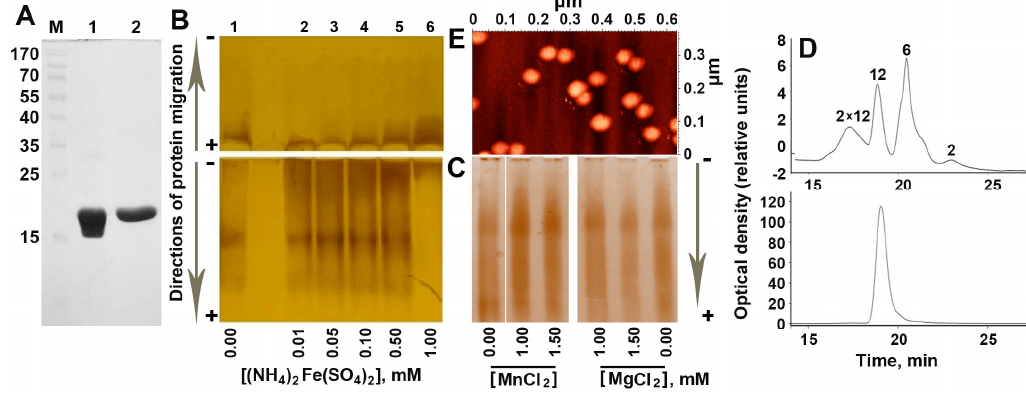
Figure 1. Oligomeric composition of the purified protein Dps. ( A ) The purity level of the protein obtained after ion exchange chromatography (lane 1) and gel filtration (lane 2) as revealed by SDS electrophoresis in 7.5% polyacrylamide gel. Protein marker lengths (M) are indicated in kDa. ( B ) Titration of purified Dps (100 μ M calculated for monomers or <8.3 μ M for dodecamers) with Mohr’s salt at pH 7.0. Lane 1—native Dps; lanes 2–6—fractional composition of the protein in the presence of 0.01–1 mM of Mohr’s salt, respectively. Vertical arrows on the left indicate the direction of electrophoretic fractionation. ( C ) The same for Dps titrated with MnCl 2 or MgCl 2 . ( D ) Elution profiles of the Dps from the gel-filtration column in the HPLC system for the purified protein (top panel) and Dps loaded with 1 mM Mohr’s salt (bottom panel). The concentration of Dps used in this experiment was 1 mg/mL (53 μ M for monomers). Oligomeric forms corresponding to the observed migration rate are indicated above the peaks. ( E ) Atomic force microscopy (AFM) image demonstrating aggregated Dps particles in the native protein. Since the freshly prepared protein samples required for AFM were fairly homogenous in oligomeric form [18], this method was not used to evaluate effects of Fe(NH4) 2 (SO 4 ) 2 .